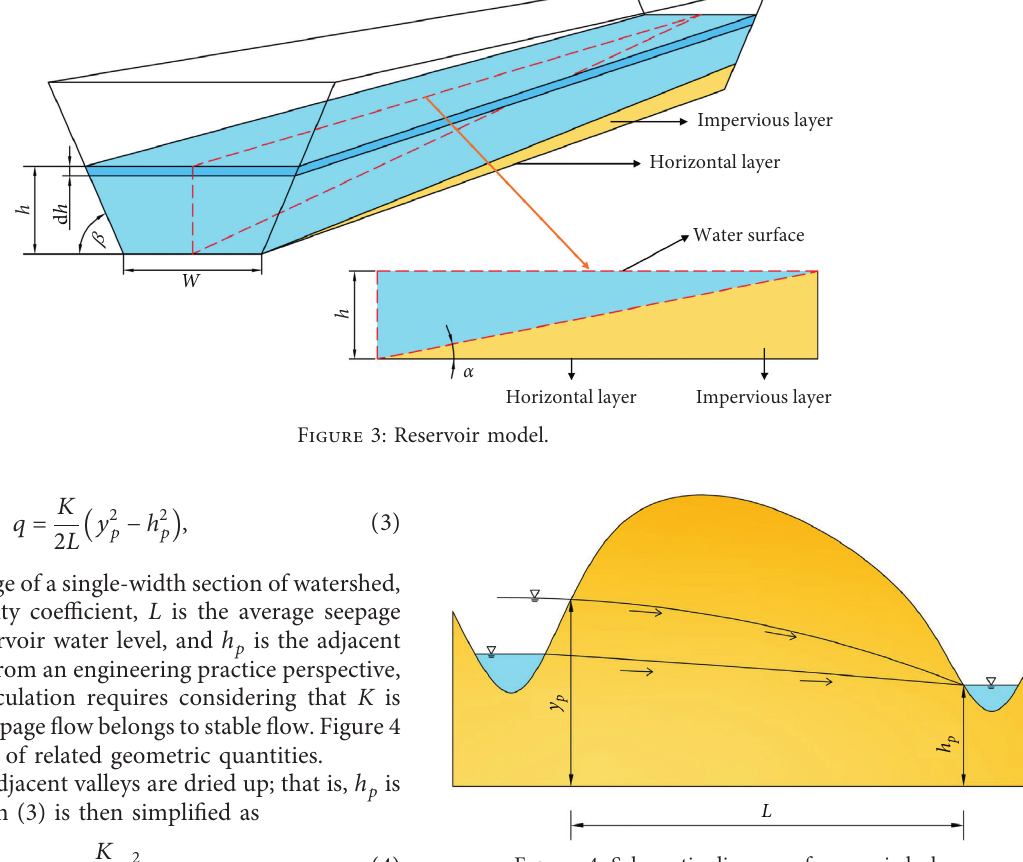
Figure 4: Schematic diagram of reservoir